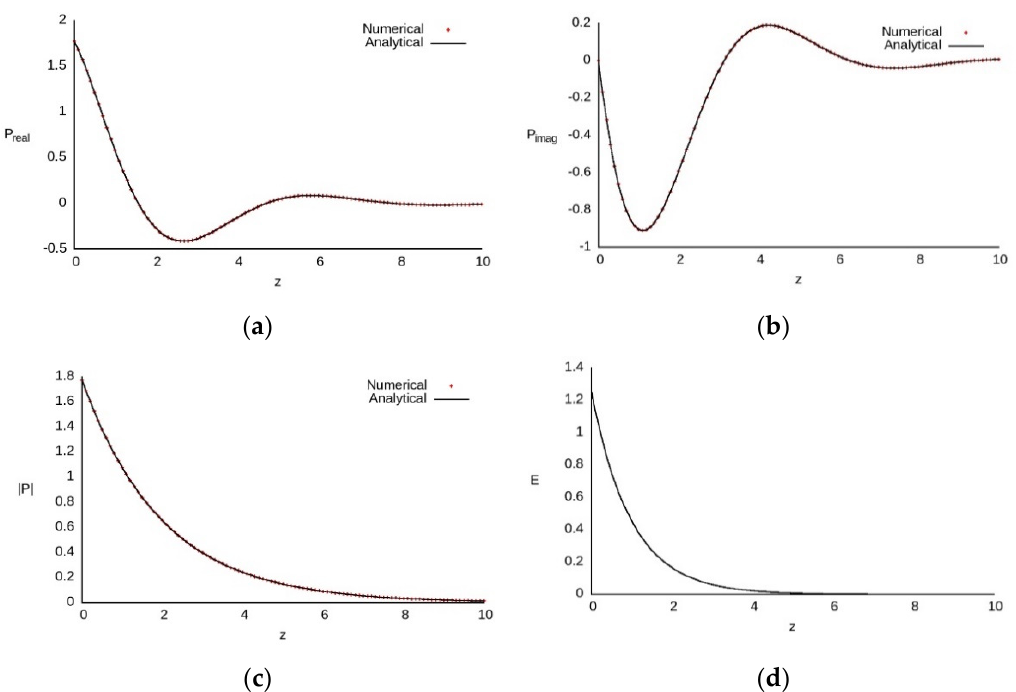
P z L (4c) evolution: real part ( a ), imaginary part ( b ), its modulus ( c ), Figure 4. The function ( , ) t and the pulse’s energy ( d ) obtained via computer simulation (red dotted line) and analytical solu- tion (black solid line) with the parameters